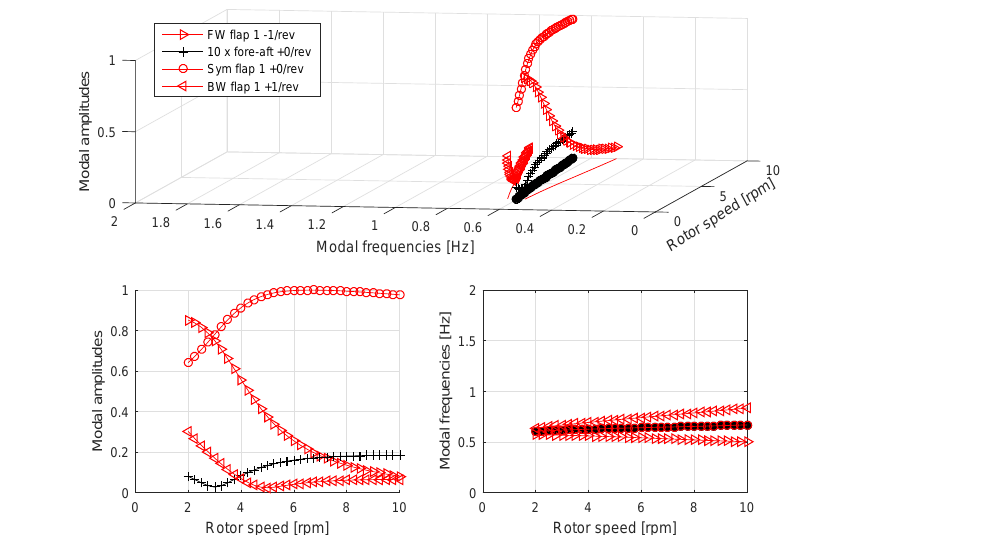
Figure 8. Harmonic modal components for the three-bladed turbine mode dominated by symmetric deflection of the rotor in the first flapwise DOF across the rotor speed range. Plot layout as in Fig.